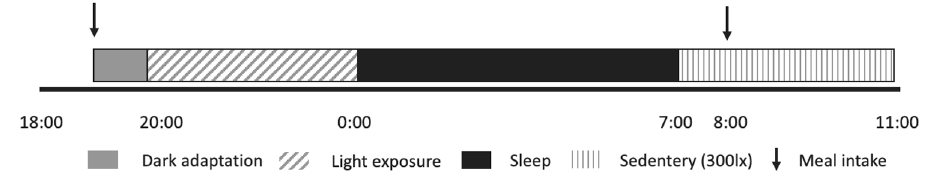
Figure 5. Study protocol. Exposure to either LED (1000 lx), OLED (1000 lx), or dim (< 10 lx) light at eye level for 4 h before sleep. Time of day indicated as relative hours with sleep time from 24:00 to 07:00.